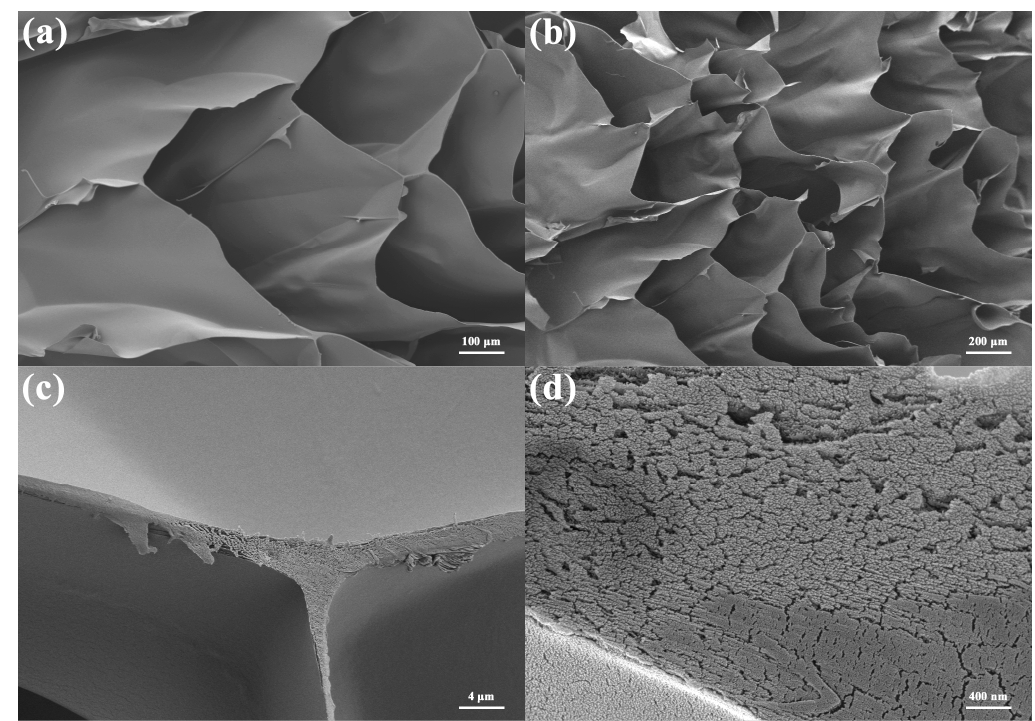
Figure 2. SEM image of pure CCNF/ANF-0 sample with different magnifications: ( a ) ×50, ( b ) ×100, ( c ) ×2000, and ( d ) ×20,000.